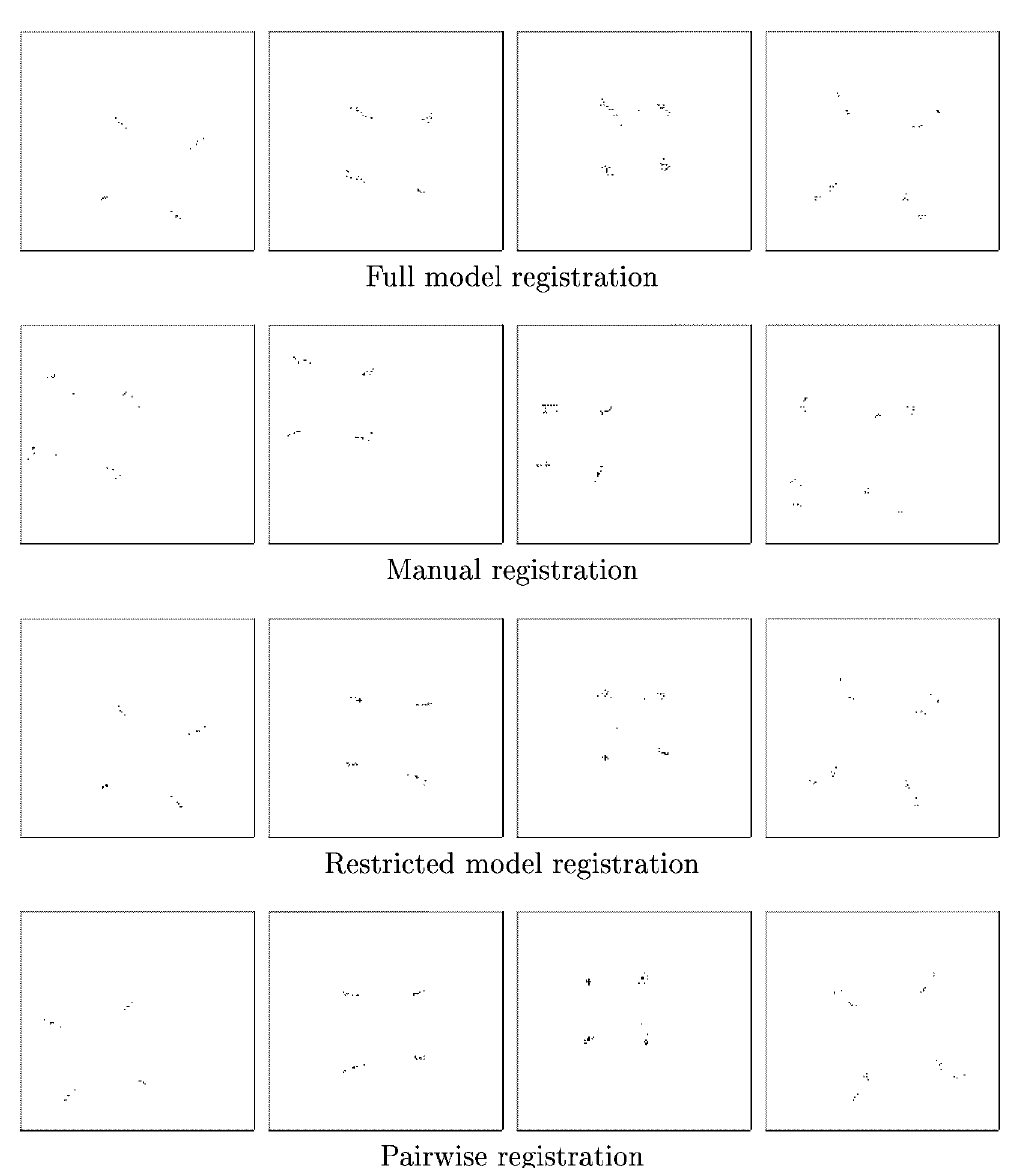
Fig. 3. The landmarks of four prostates were compared using different optimisation methods compared to manual registration. The restricted model works the same as the full model, but the needles must be orthogonal to the slice planes. The images shows all landmarks as seen from the top of the stack of slices using parallel projection. The 2D line up of points in the full model is not a coincidence – the slices are stacked so that the 2D projection of the 3D line is well shown. The rightmost case is the one where the automatic registration was marked as “worse” than the manual registration. Two groups of slices can be seen. Investigation of this case reveals that this is because of the treatment in the fixation phase, where the lower and upper half of slices has been treated